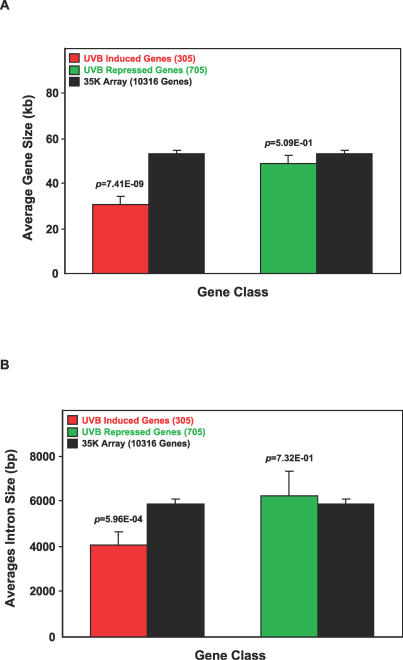
UVB Response and Gene SizeGene (A) and intron (B) size data were retrieved for 305 of 332 UVB-induced, 705 of 770 UVB-repressed, and 10,316 of 14,605 35,000 unique mouse genes (by UniGene Cluster ID criteria) using the Ensembl (National Center for Biotechnology Information m34 Assembly) and National Institute on Aging Gene Index 5.0 databases. The size data were averaged for each UVB response class and were then compared, using a Student's t-test, to the gene and intron size averages for 10,316 unique genes on the 35,000 array. Significance values are shown above each UVB response class, and error bars are ±SEM. Gene and intron sizes are represented here on a linear scale, but were log2-transformed prior to t-test analyses, due to the non-normal distribution of the data. Nonparametric Mann-Whitney U tests on the untransformed data yielded similar results.